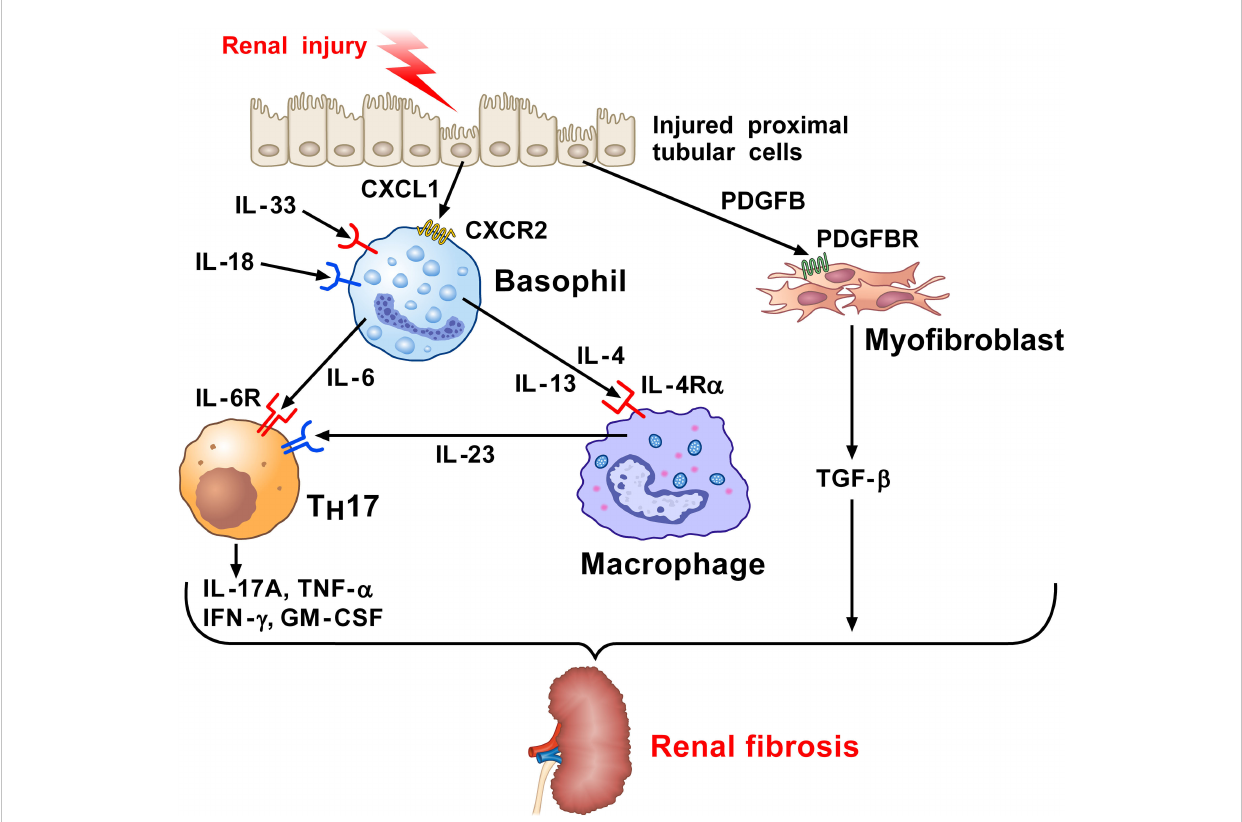
FIGURE 2 Kidney and wild-type mice subjected to unilateral ureter obstruction (UUO) surgery revealed the presence of neutrophils, monocytes/macrophages, dendritic cells (DCs), and basophils (71). Injured proximal tubular cells (PTs) in UUO kidney express Il34 , Cxcl10 , and the key pro fi brotic factor (71), platelet derived growth factor subunit B (PDGFB). PDGFB released by injured tubular activates the PDGFB receptor (PDGFBR) on fi broblasts to release TGF- b . Pro fi brotic PT cells participate in the recruitment of myeloid and lymphoid cells and the local fi broblast activation. CXCL1 released from PT cells induces the recruitment of basophils through the engagement of CXCR2. Basophils in UUO kidney can be activated by IL-33 and IL-18 released from the stroma to secrete IL-6. This cytokine favors T H 17 differentiation from CD4 + T cells in UUO kidneys. IL-17A and TGF- b released from T H 17 cells contribute to renal fi brosis. IL-4 and IL-13 released from activated basophils can contribute to macrophage activation (127 – 130). PDGF released from injured PT cells activates the PDGFR on myo fi broblasts causing the release of TGF- b . Macrophages are also a major source of IL-6. Collectively, these fi ndings indicate that basophils and their mediators contribute to kidney fi